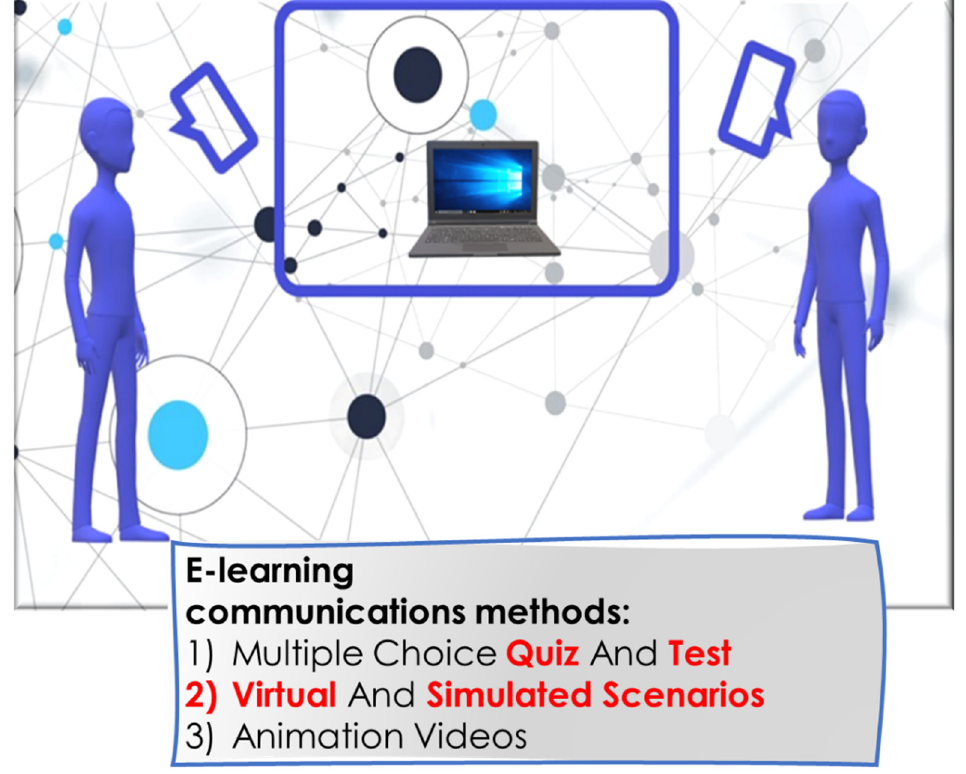
Figure 4. Webinars on multiple topics held online.